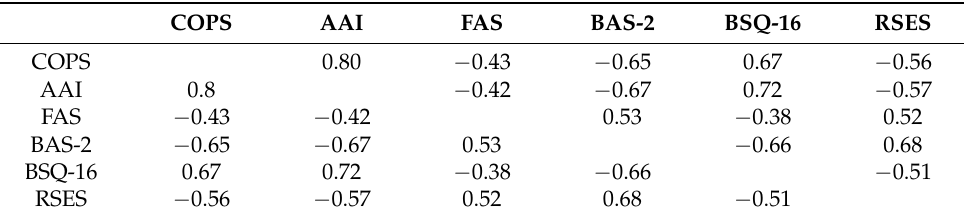
Table 3. Spearman’s rank correlation coefficient (r S ) for total scores of all questionnaires that were used in the study ( p < 0.0001 for all correlations). COPS AAI FAS